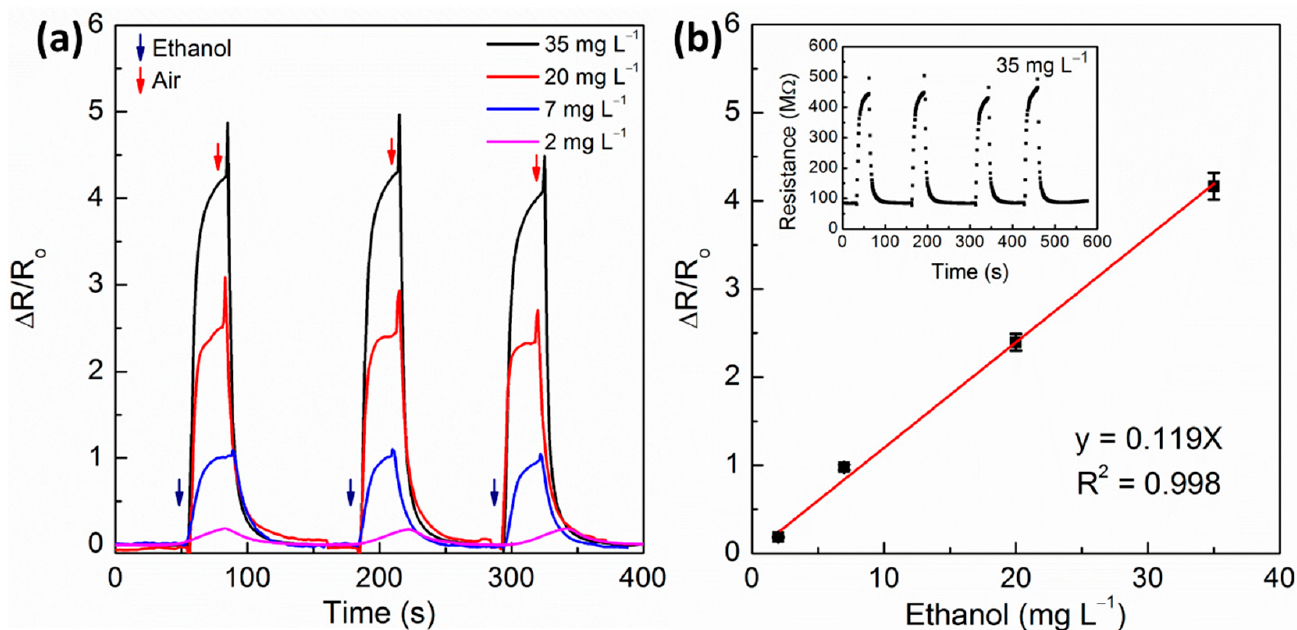
Figure 7. ( a ) Nanocomposite α -Fe 2 O 3 /Ag 3.0 wt% sensor response transients to consecutive cycles of exposure/purge to different ethanol vapor concentrations. ( b ) Linear relationship between concentration and relative resistance change. Inset: Electrical resistance as a function of time to 35 mg L − 1 of ethanol.